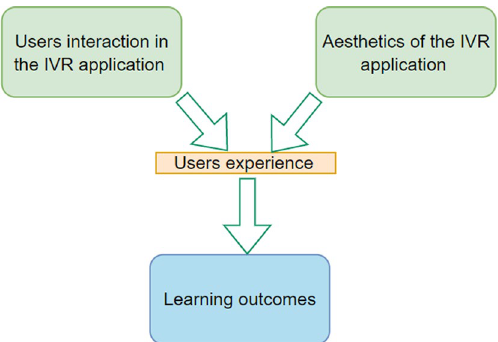
Fig. 6 Thematic map of the qualitative analysis of users’ experiences with the IVR